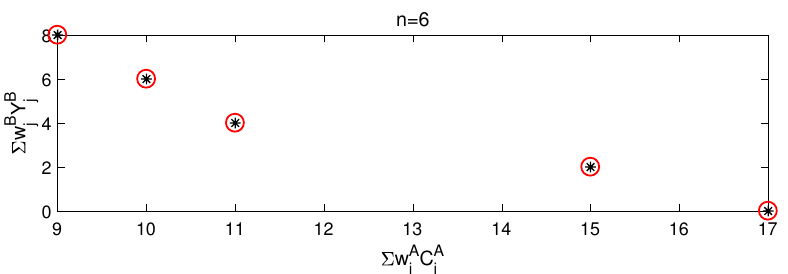
Figure 2. The black stars are the points generated by Algorithms 1 and 2, the red circles are points generated by Algorithm 3.